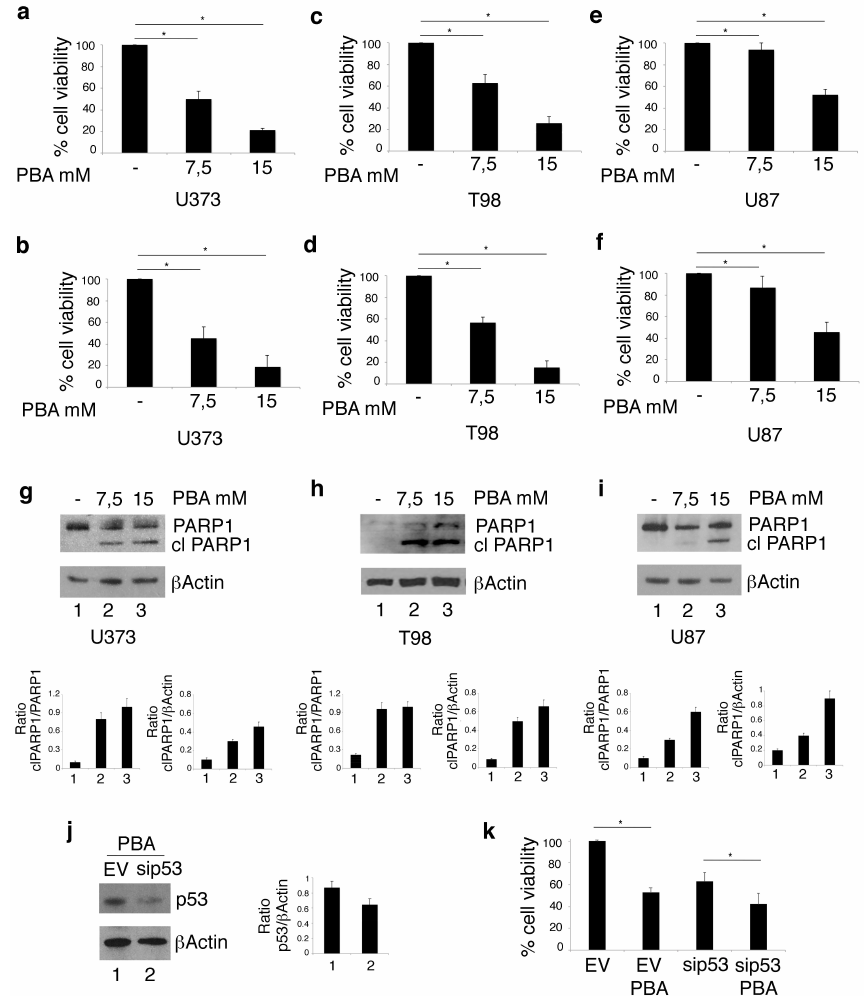
Figure 1. Phenylbutyrate (PBA) reduces cell survival and induces cell death in U373 and T98 glioblastoma cells more e ffi ciently than in U87 glioblastoma cells. After 24 h of culture in the absence or in the presence of 7.5 mM or 15 mM PBA, cell survival of U373, T98 and U87 cell lines was evaluated by trypan blue exclusion assay ( a , c and e respectively) and by MTT assay ( b , d and f